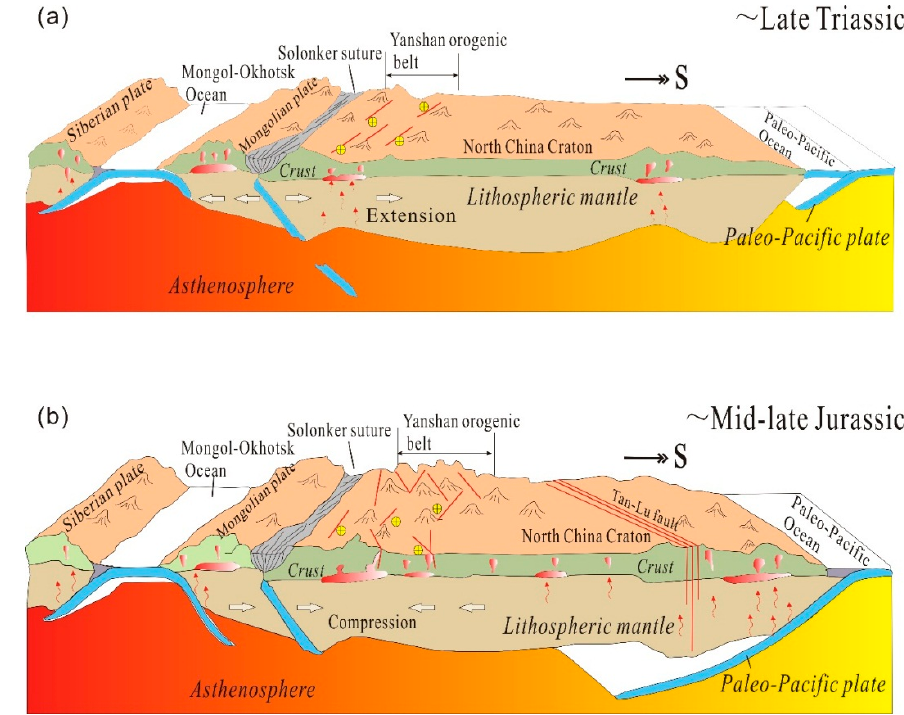
Figure 18. A simplified mineralization model of the Jidong gold province, modified from Ma [92]. ( a ) gold mineralization model and tectonic setting of Late Triassic in Jidong area; ( b ) gold mineralization model and tectonic setting of Mid–Late Jurassic in Jidong area.